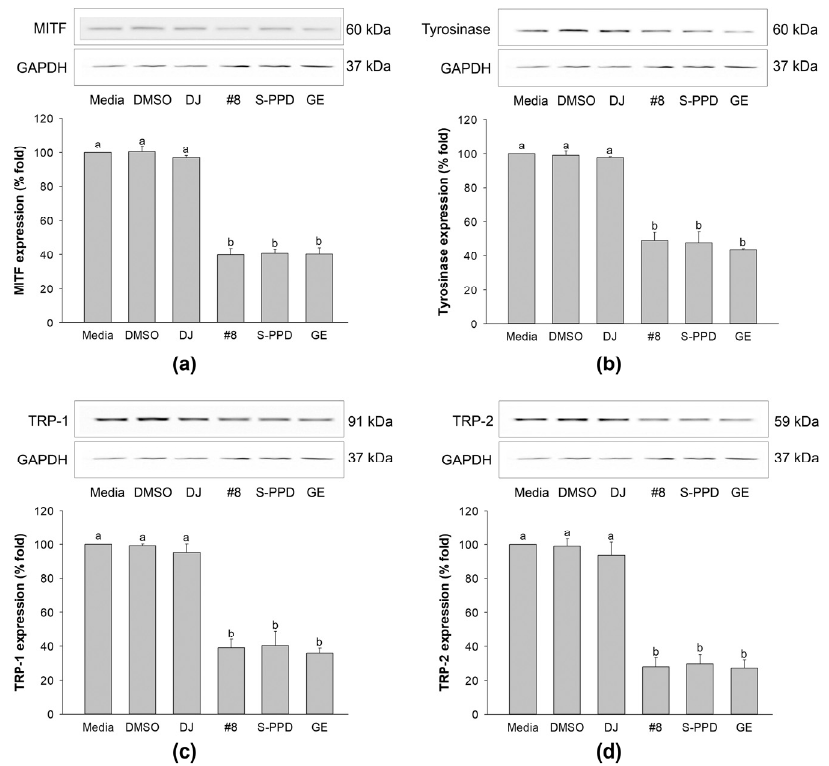
Figure 8. Effects of the transgenic rice seed extracts on melanogenesis-related proteins. Effects on ( a ) MITF, ( b ) tyrosinase, ( c ) TRP-1, and ( d ) TRP-2 expression levels. DJ, #8, and GE concentrations were 100 µg/mL. S-PPD and DMSO concentrations were 700 pg/mL and 0.1%, respectively. Data are shown as means ± standard deviations. Lowercase letters indicate significant differences among treatments at p < 0.05.